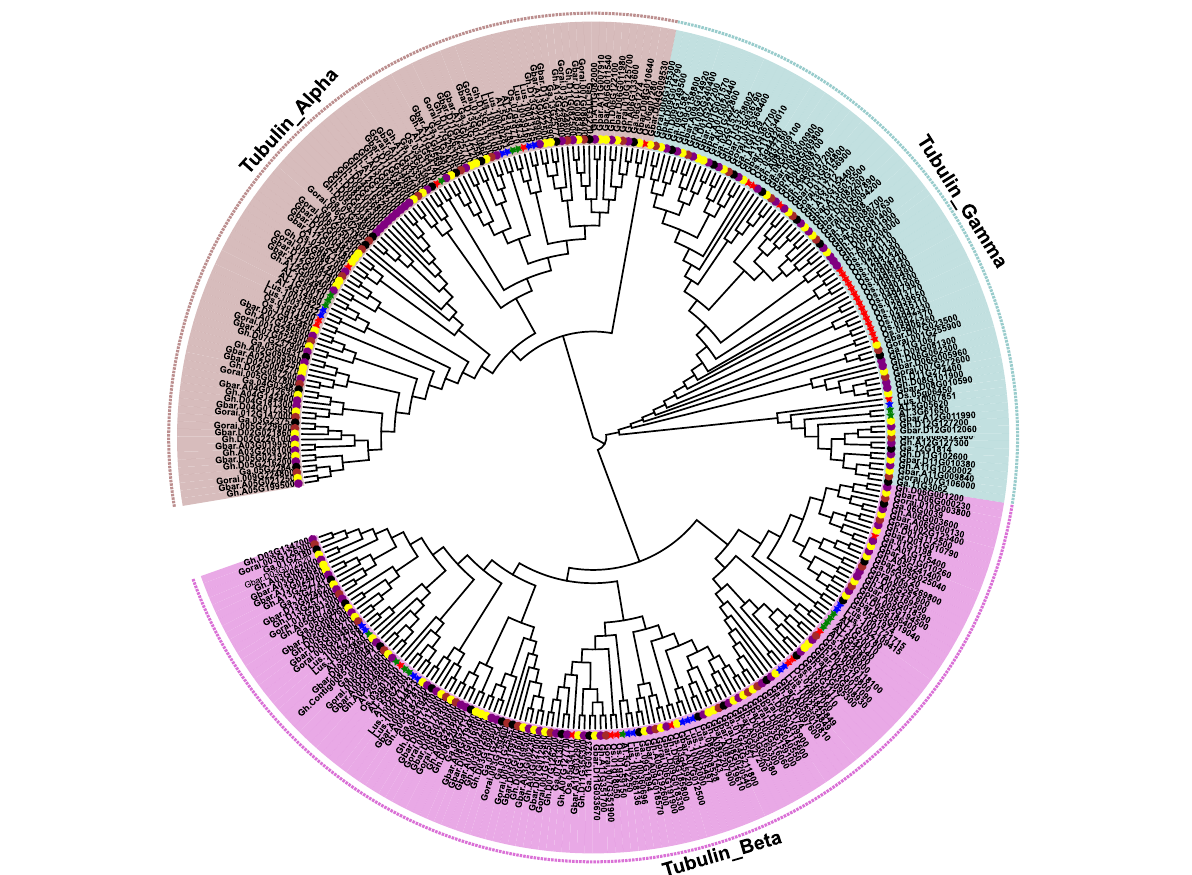
Fig. 1 Phylogenetic and evolutionary analysis of the tubulin genes family in different plant species. An unrooted phylogenetic tree of tubulin protein sequences from O. sativa , A. thaliana , L. usitatissimum , G. arboreum , G. barbadense , G. raimondii , and G. hirsutum . The phylogenetic